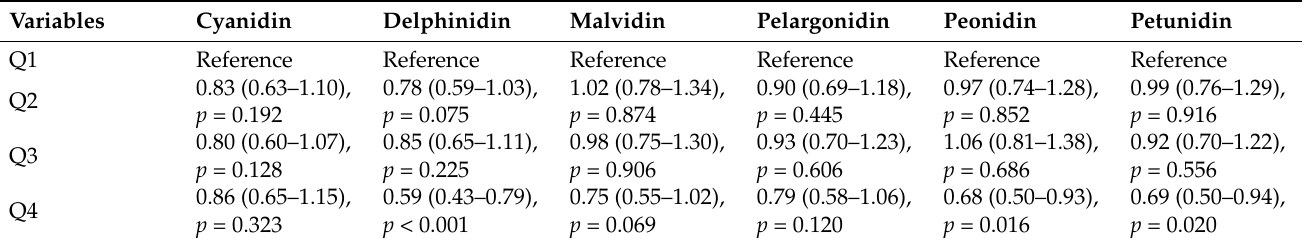
Table 3. Associations between the subclasses of anthocyanidin intakes and renal cancer risk.